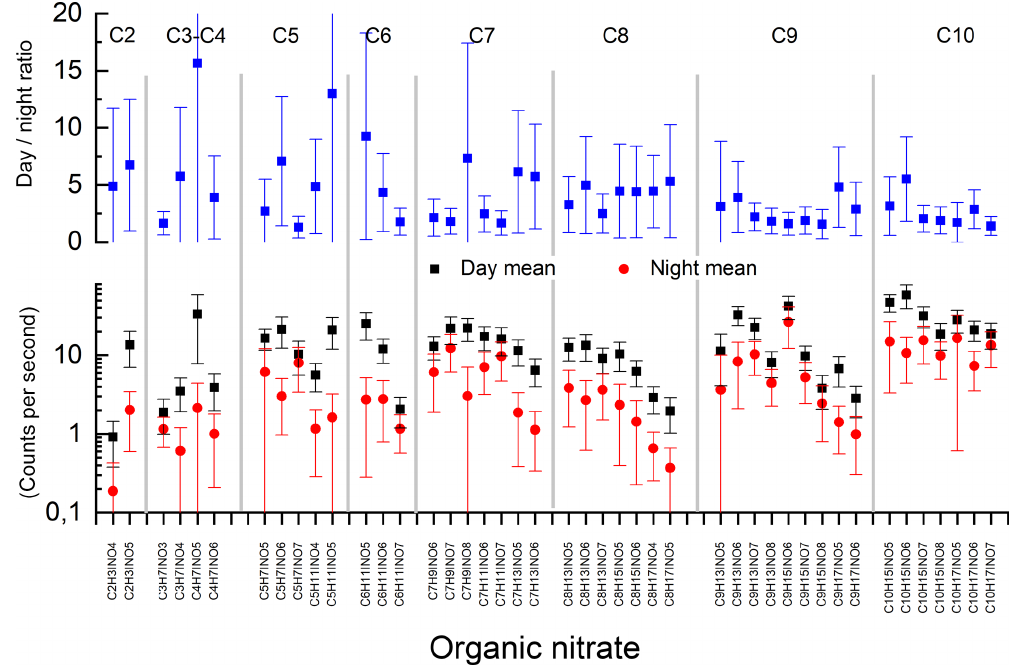
Figure 9. Campaign mean signals for organic nitrates measured by the HR-L-ToF-CIMS. The HR-L-ToF-CIMS was not calibrated; thus only the raw signal (counts per second) at each mass is